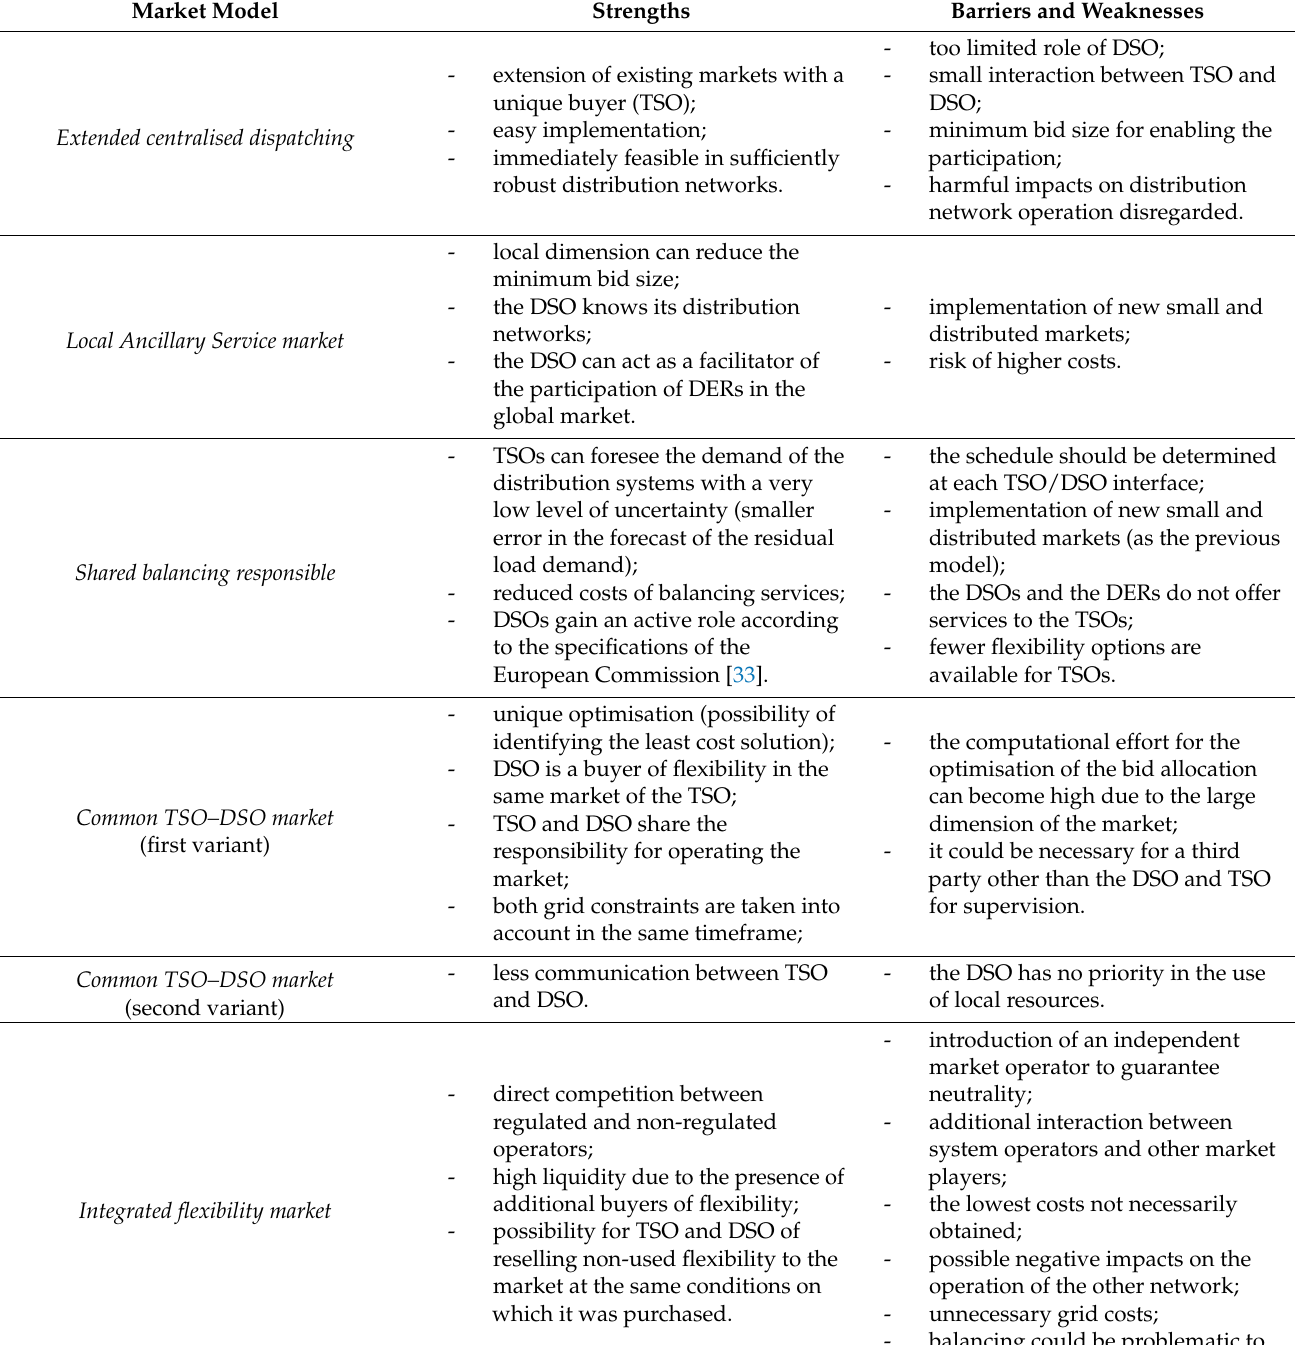
Table 1. Strengths, barriers and weaknesses of the proposed market